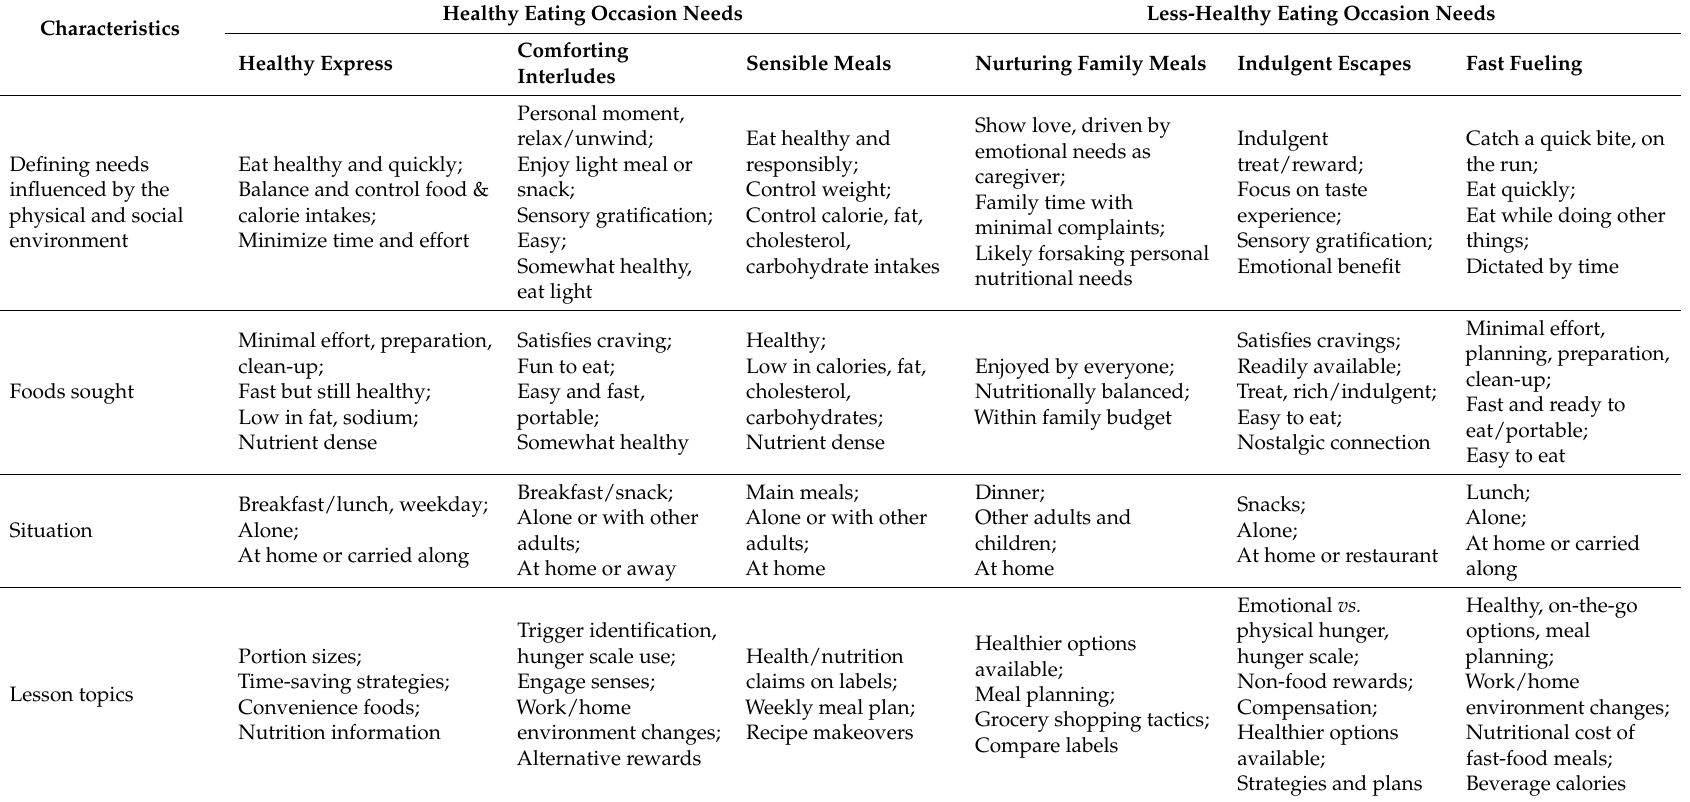
Table 1. Characteristics of needs within eating occasions and corresponding lessons delivered by dietitians to women in the intervention group.